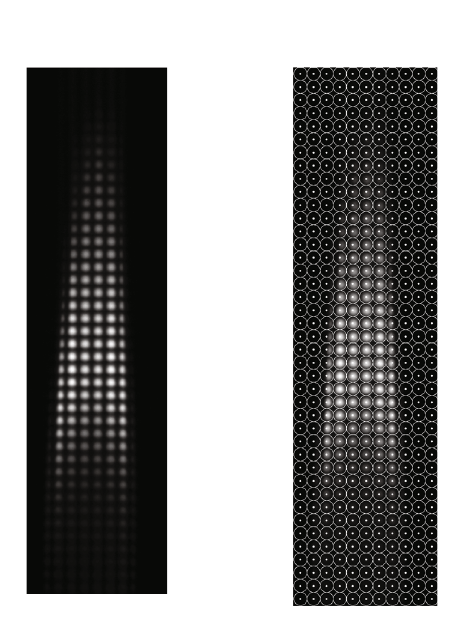
Figure 16: The pretreatment of the raw light fi eld